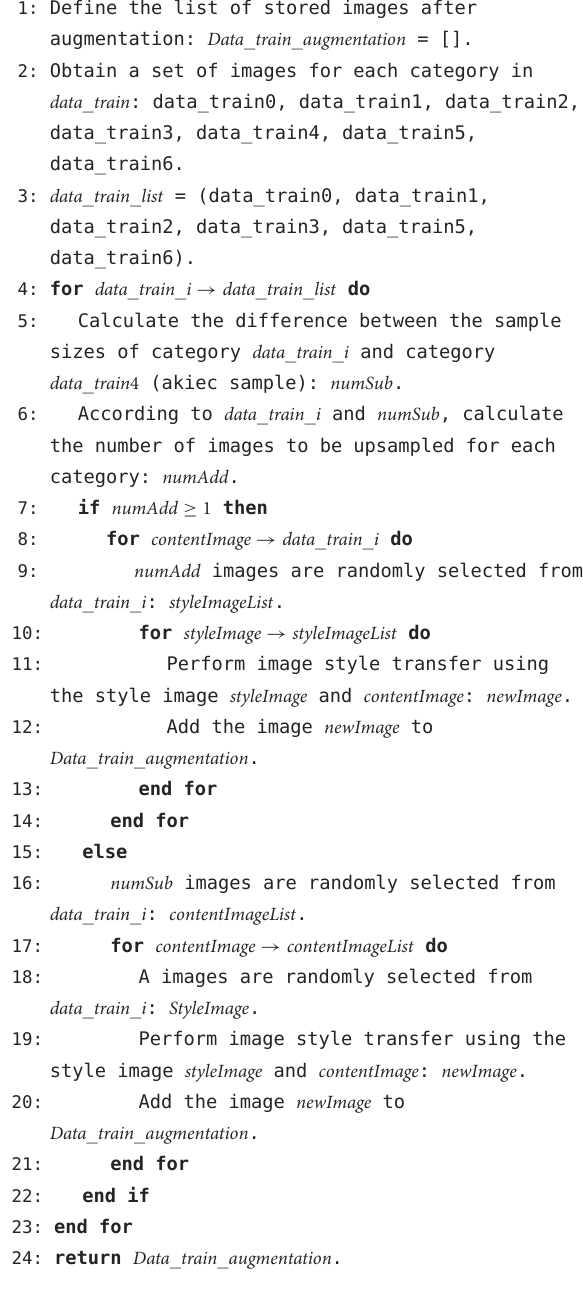
Carcinoma/Bowen’s disease (akiec), Vascular lesions (angiomas, angiokeratomas, pyogenic granulomas, and hemorrhage) (vasc), and Dermatofibroma (df). The corresponding amounts of image data are 327, 514, 1,099, 115, 6,705, 1,113, and 142, respectively. The proportion of each category is shown in Figure 2A. Typical images for each category are shown